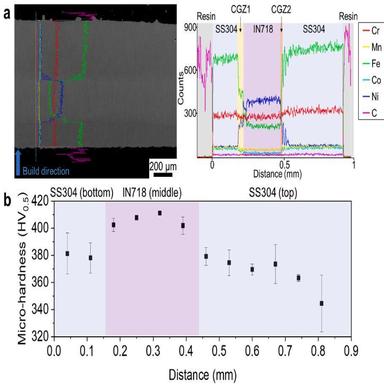
(A) EDX line analysis and (b) microhardness along the build direction at the middle cross-section of the Case-4 sample.